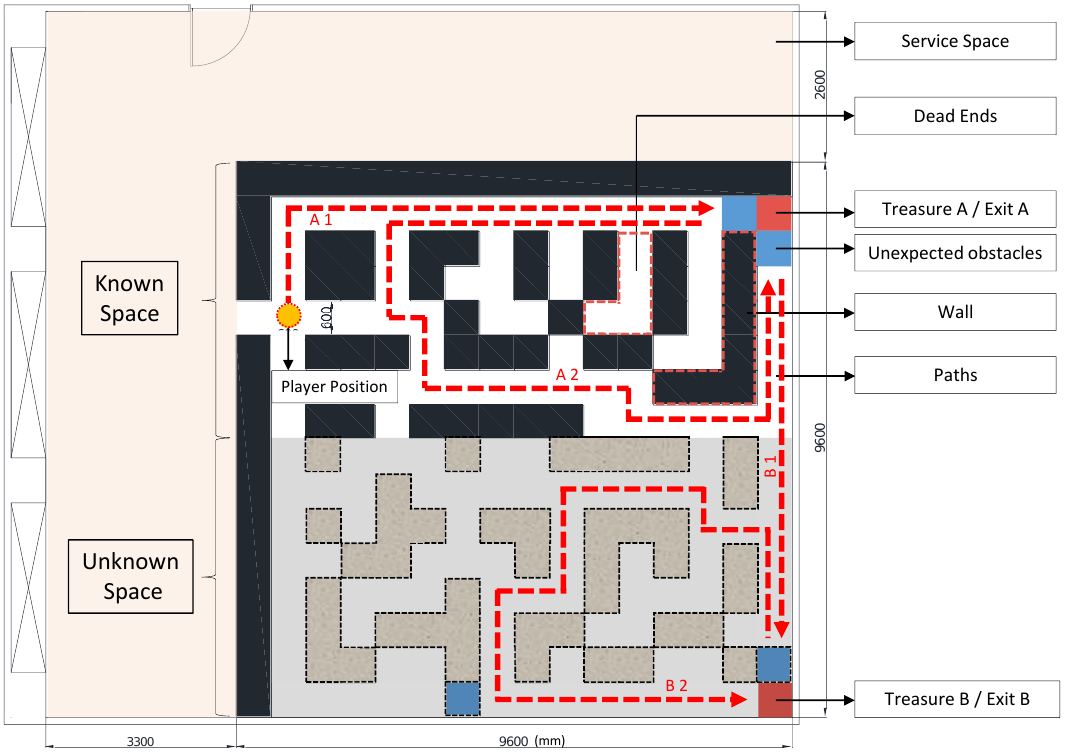
Figure 4. Maze layout (mm).